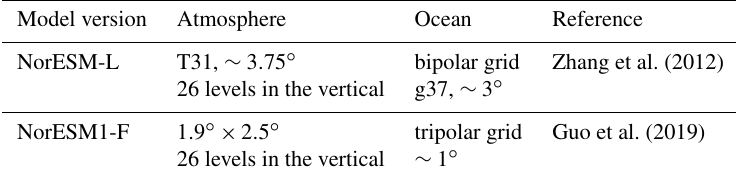
Table 1. The model description.